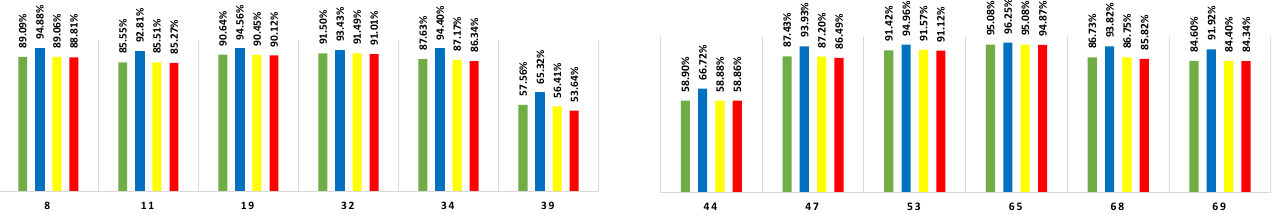
Figure 10. Relative changes from the reference case/scenario, in terms of supplied thermal energy (blue), electricity for pumping (orange), overall operating sources (grey), cost (yellow), and CO 2 emissions (light blue). 0.95%